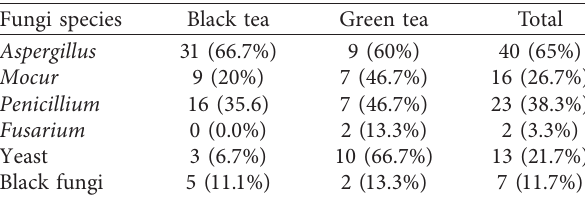
Table 4: The frequency of fungal species contamination in black and green tea